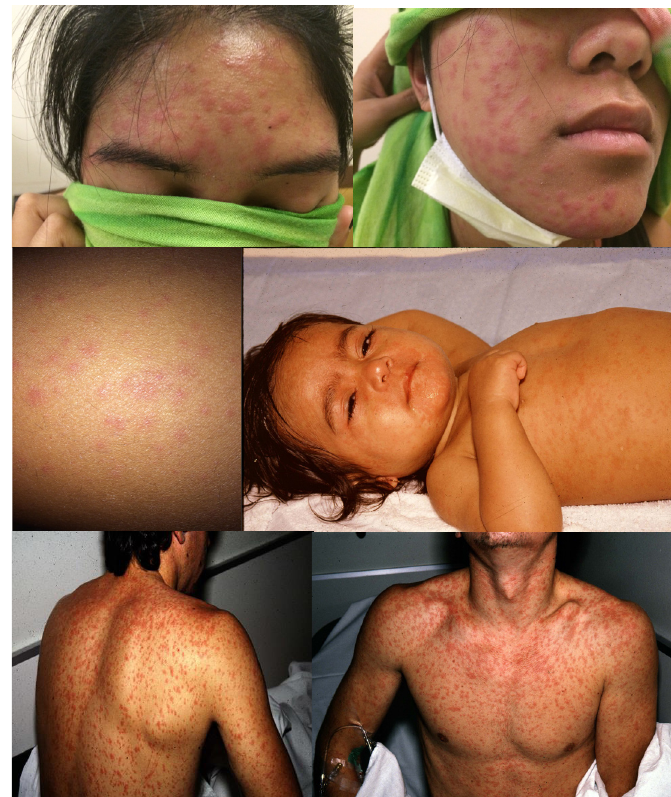
Figure 3. Measles rash. Photos used with permission of Michael J. Burns,